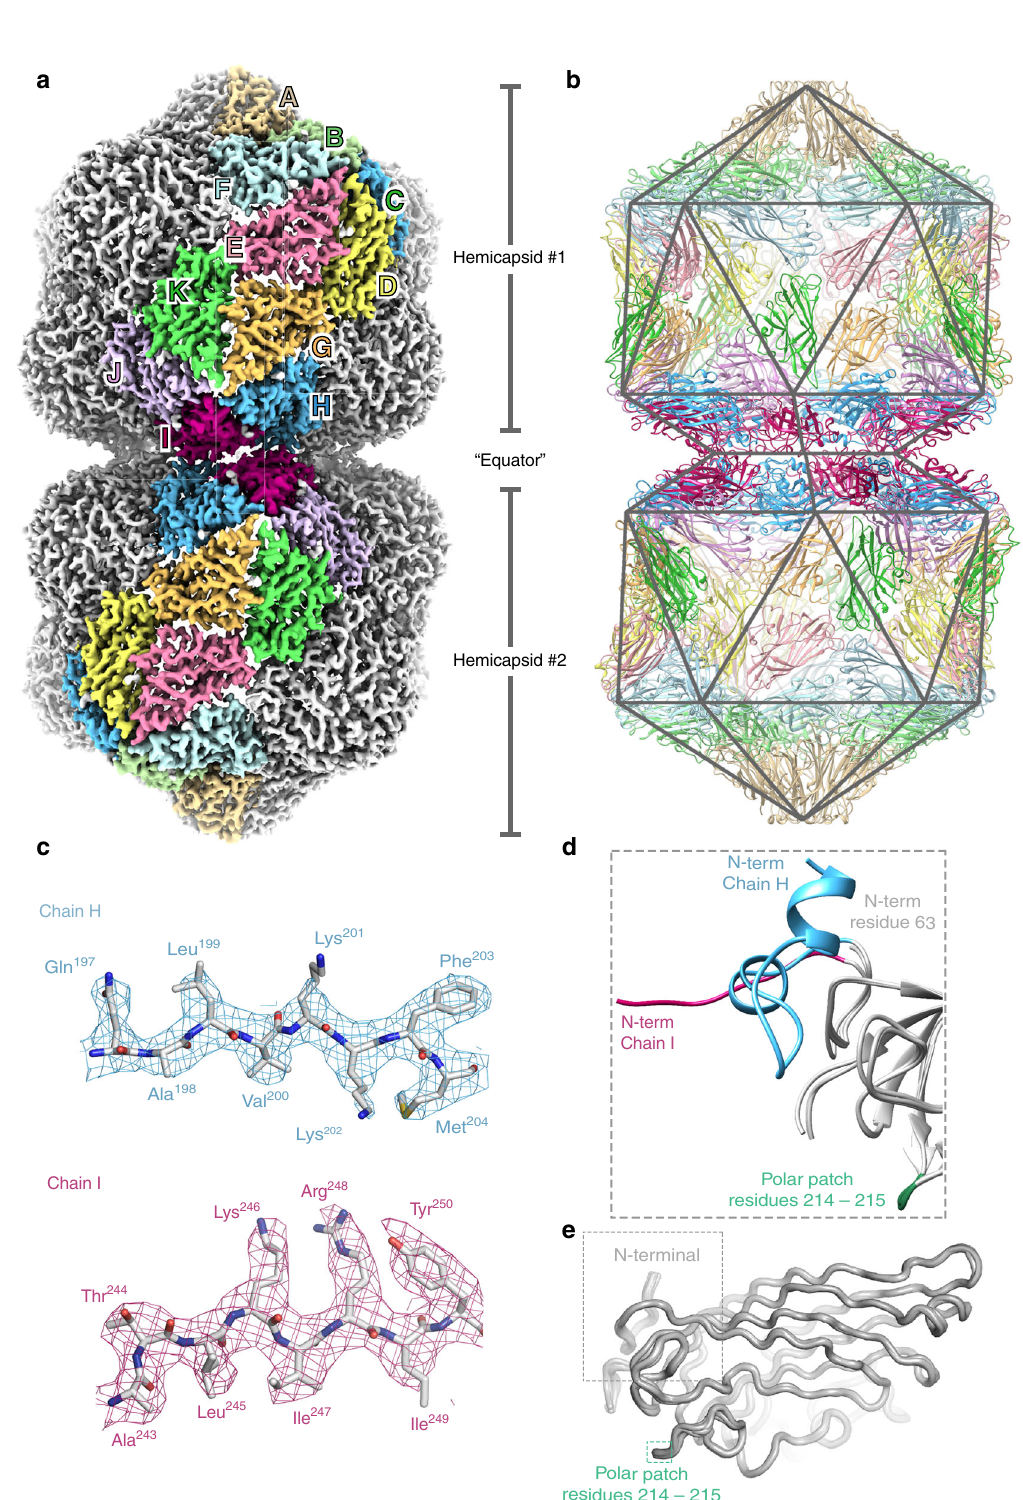
Fig. 1 The structure of Ageratum yellow vein virus. a EM density for AYVV at 3.3 Å resolution. The density is segmented and colored to highlight the 11 unique copies of the AYVV CP in the D5 asymmetric unit (labeled A-K). b Complete atomic model for all 110 subunits in the capsid, with a polyhedral cage showing the symmetry of the particle. The fi vefold symmetry axis is vertical and through the center of the particle in this view. c Representative regions of EM density with the corresponding section of atomic model. d A “ zoomed in ” view of the N-terminal segment of all 11 unique CPs aligned. The N-terminal of chain I, chain H and the remaining 9 CPs is highlighted. The position of a polar patch (residues 214 – 215) is also shown. e Alignment of residues 64 – 256 from all 11 unique copies of the CP. The RMSD between structures is ~0.2 – 0.3 Å. The position of the N terminal and the polar patch of residues is